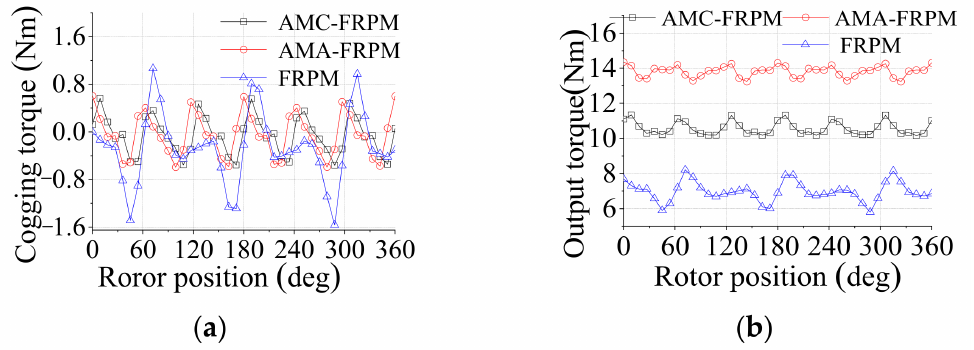
Figure 17. Torque performances of the three machines. ( a ) Cogging torque. ( b ) Output